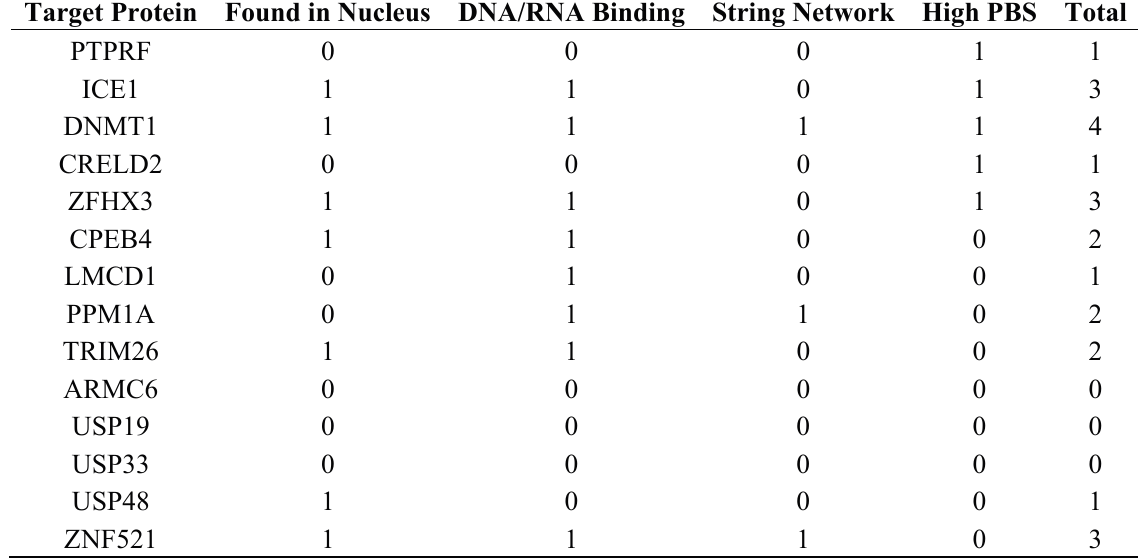
Found in Nucleus DNA/RNA